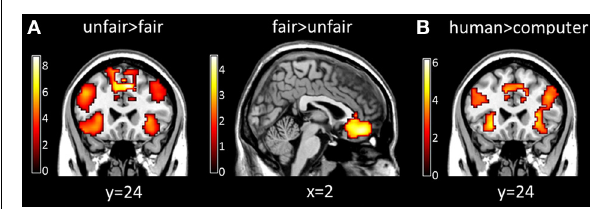
FIGURE 3 | Brain activations influenced by fairness and proposer type at proposal presentation. (A) Maps of the t statistics for the contrast [unfair > fair] showing activation of the bilateral insula, ACC, and lateral PFC, and for the contrast [fair > unfair] showing activation of the medial prefrontal cortex. (B) Map of the t statistic for the contrast [human > computer] showing activation of the bilateral insula, ACC, medial prefrontal